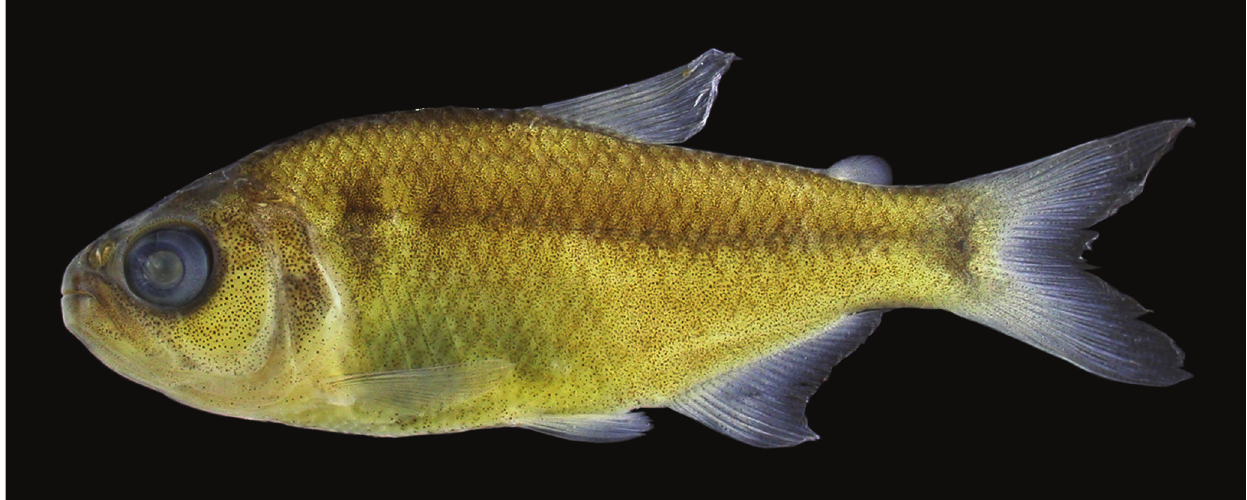
Fig. 1. Moenkhausia dasalmas , holotype, UFRGS 11221, 42.9 mm SL, tributary of rio das Almas, Cavalcante, Goiás, Brazil.